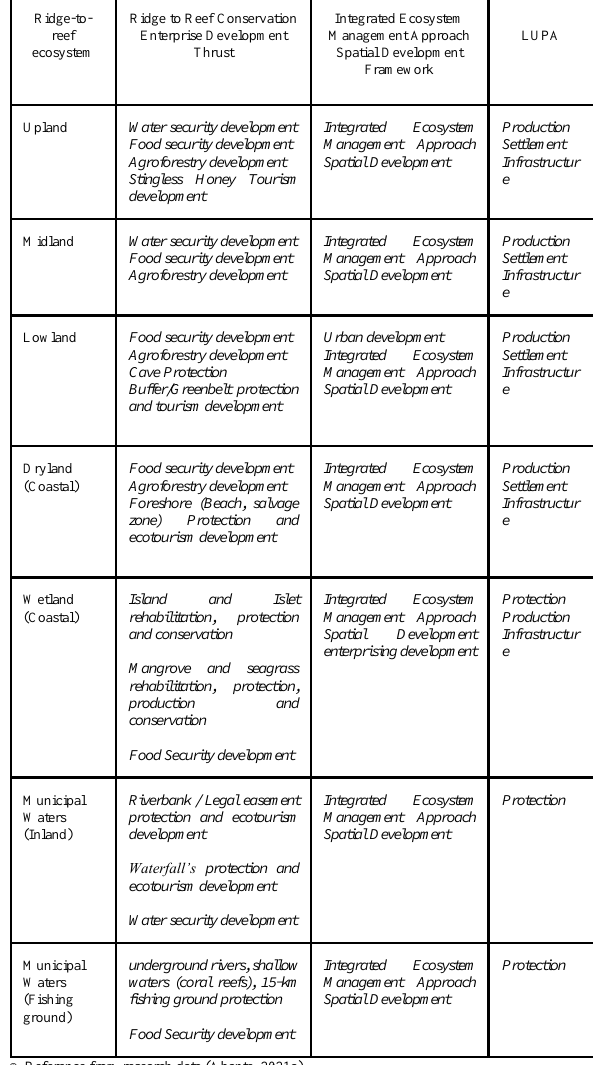
Figure 10 . Parameters for land use reversion